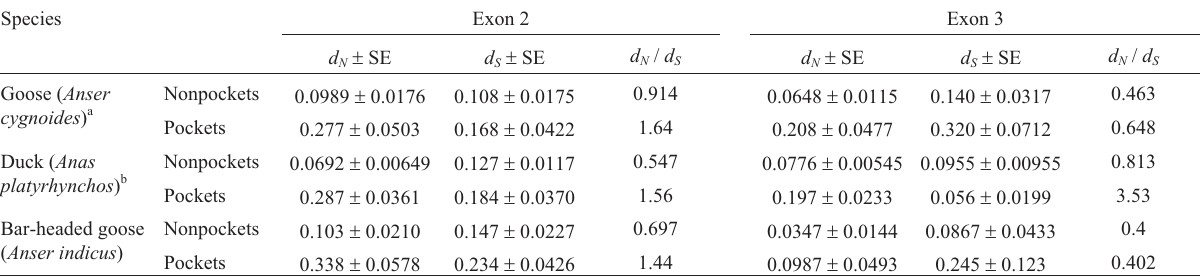
Table 2 - Comparison of synonymous ( d S ) and nonsynonymous ( d N ) substitution rates in exon 2 and exon 3 (encoding (cid:2) 1 and (cid:2) 2 domains separately) of MHC class I heavy chain among three Anseriformes birds: goose, duck and bar-headed goose (our study).